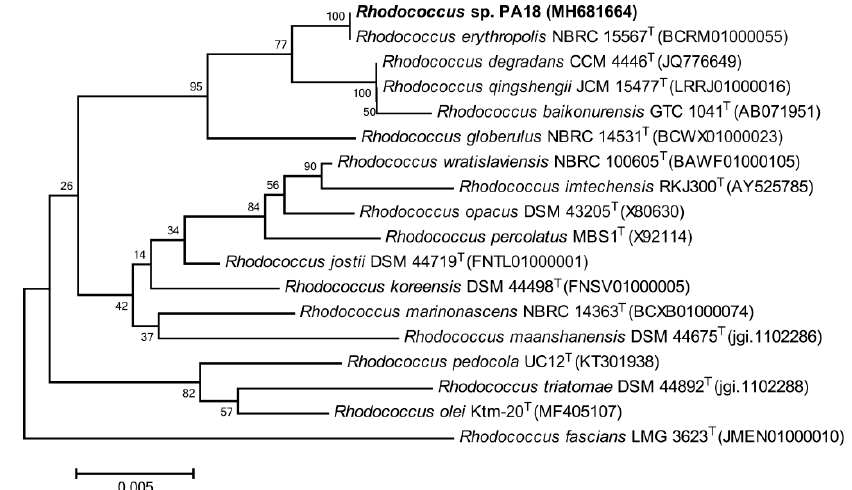
Figure 1. Neighbor-joining phylogenetic tree shows the position of strain picolinic acid 18 (PA18) among some members of the genus Rhodococcus , based on the 16S rDNA sequences.